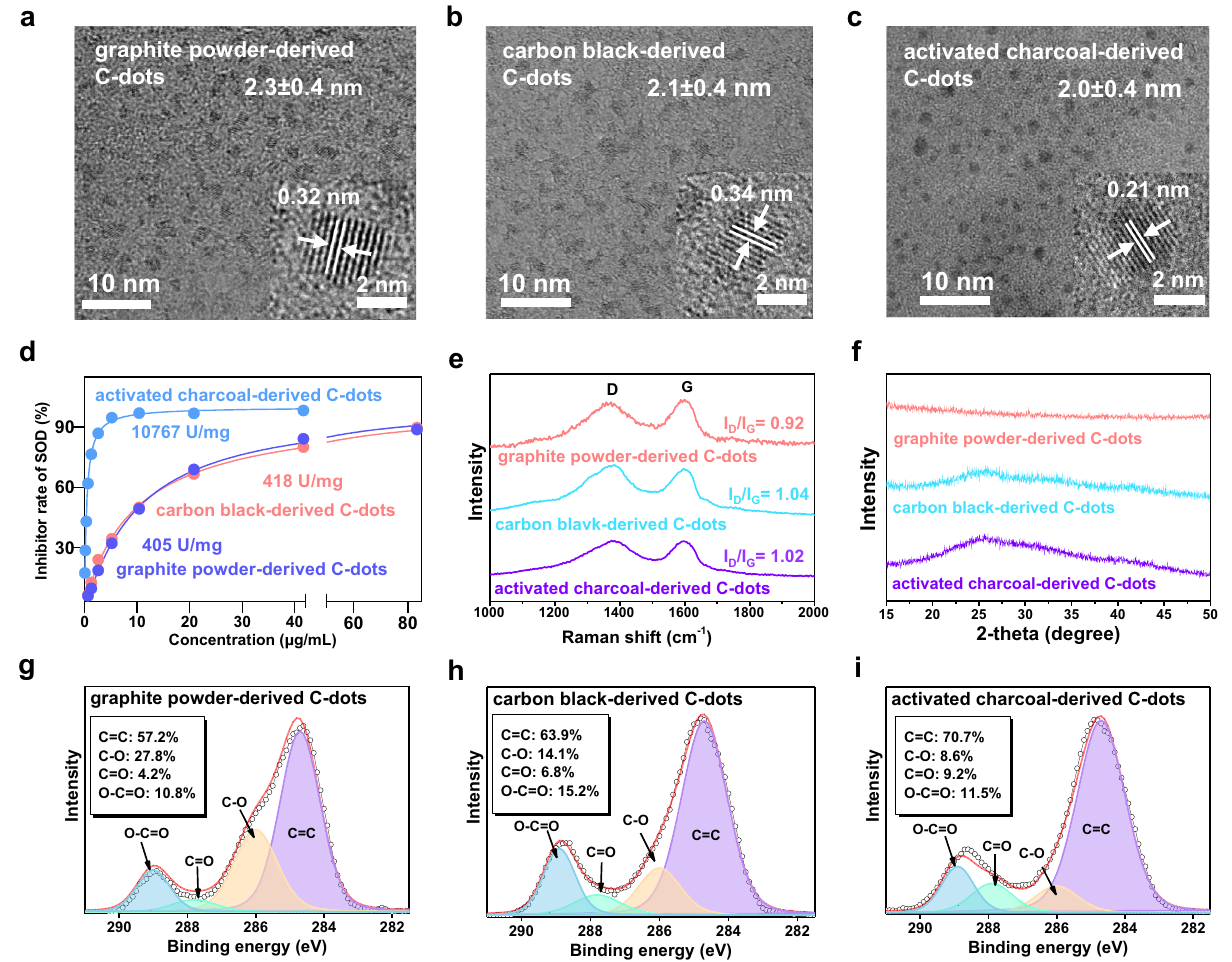
Fig.1|CharacterizationofC-dotSODnanozymes. TEM(Inset:HR-TEM)imagesof C-dots prepared from ( a ) graphite powder, ( b ) carbon black, and ( c ) activated charcoal. d The SOD-like activities of C-dots prepared from graphite powder, car- bon black, and activated charcoal. e Raman spectra and ( f ) XRD patterns of C-dots preparedfromgraphitepowder,carbonblack,andactivatedcharcoalasindicated.